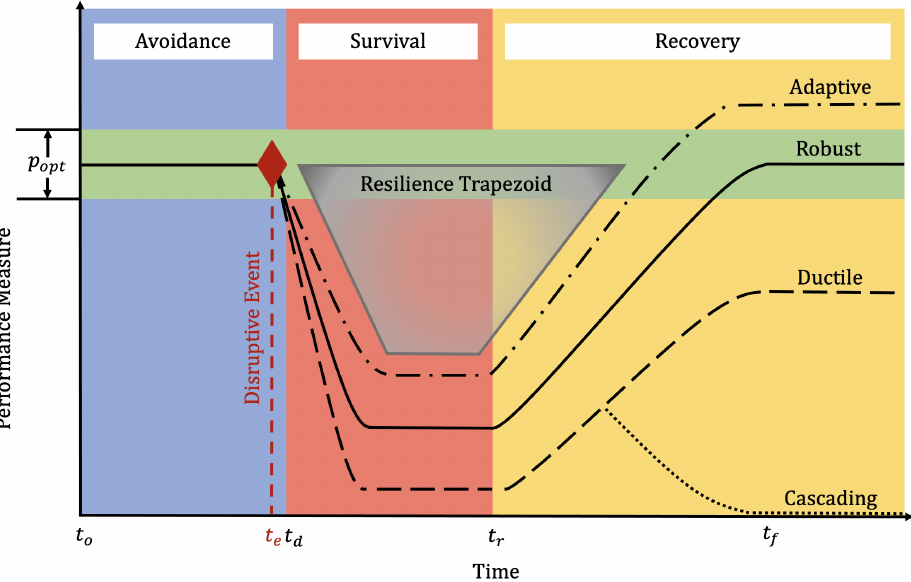
Figure 1. Generic microgrid resilience curves before, during, and after a disruptive event. Recovery behavior is dependent on a microgrid’s absorptive, adaptive, and restorative capacities